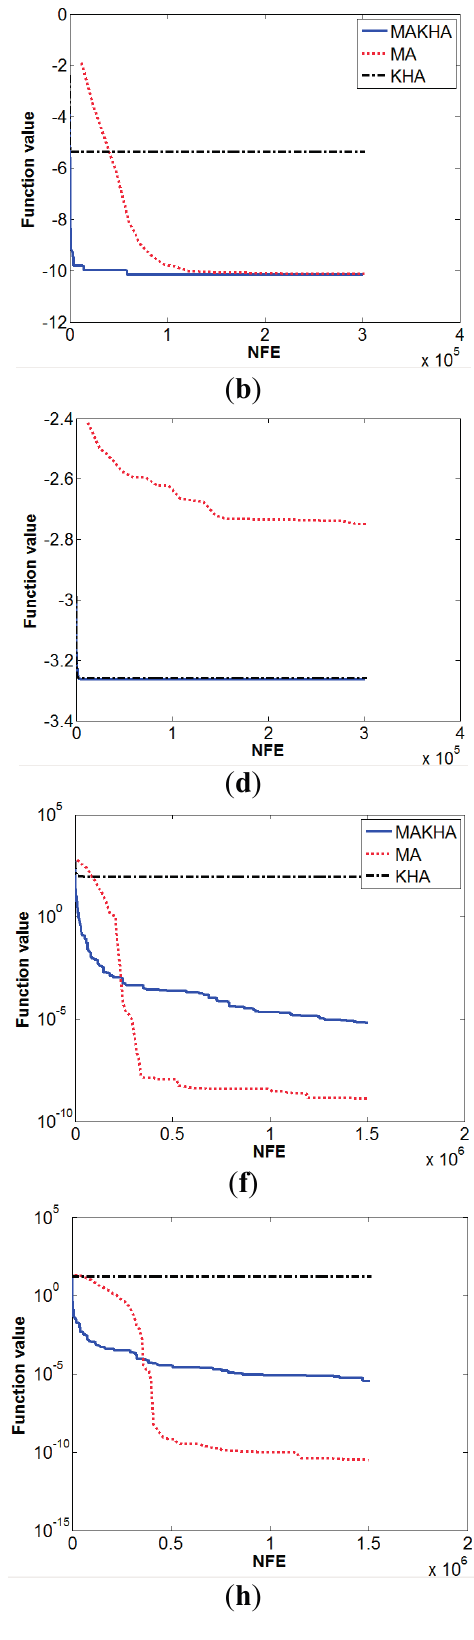
Figure 7. Evolution of mean best values for MA, KHA and MAKHA for: ( a ) Extended cube, ( b ) Shekel, ( c ) Sphere, ( d ) Hartman, ( e ) Griewank ( f ) Rastrigin, ( g ) Rosenbrock, and ( h ) Sine Envelope Sine